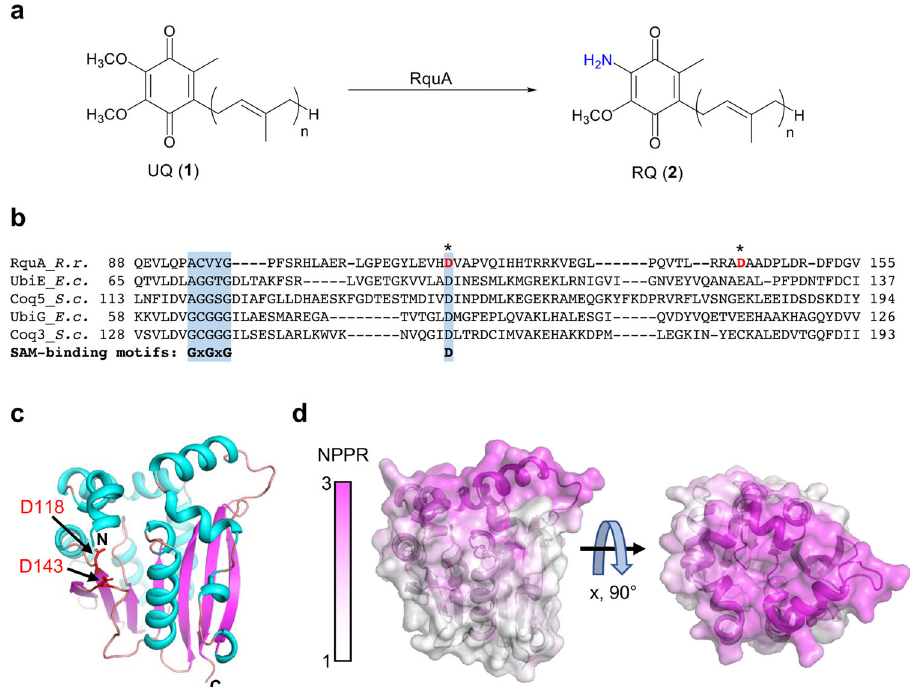
Fig. 1 Biosynthesis of rhodoquinone and a structural model of RquA. a In select bacteria and protists, RquA converts ubiquinone (UQ, 1 ) to rhodoquinone (RQ, 2 ). b The amino acid sequence of RquA was aligned with related methyltransferases. Sequences of RquA from R. rubrum ( R.r .); UbiE and UbiG from E. coli ( E.c .); and, Coq3 and Coq5 from S. cerevisiae ( S.c .) were aligned using Clustal Omega 63 . Characteristic S -adenosyl- L -methionine (SAM) binding motifs 21 are indicated by light blue shading. D118 and D143 of RquA, which participate in interactions with SAM in related methyltransferases, are colored red and indicated with *. c An RquA model was predicted by AlphaFold2 64 using a Google co-laboratory webserver 65 and visualized as a cartoon using PyMol (Schrödinger, LLC). The fi rst 38 residues, which are not converged or predicted with high con fi dence by AlphaFold2, are omitted for clarity. α -Helices and β -sheets are colored cyan and magenta, respectively. Aspartic acid residues, D118 and D143, which potentially bind SAM, are colored red. d A surface representation is shown of the RquA model colored by a nonpolar-polar ratio (NPPR) as calculated using the Protein-Sol webserver 66 . A large hydrophobic patch (magenta) is present near the putative SAM-binding